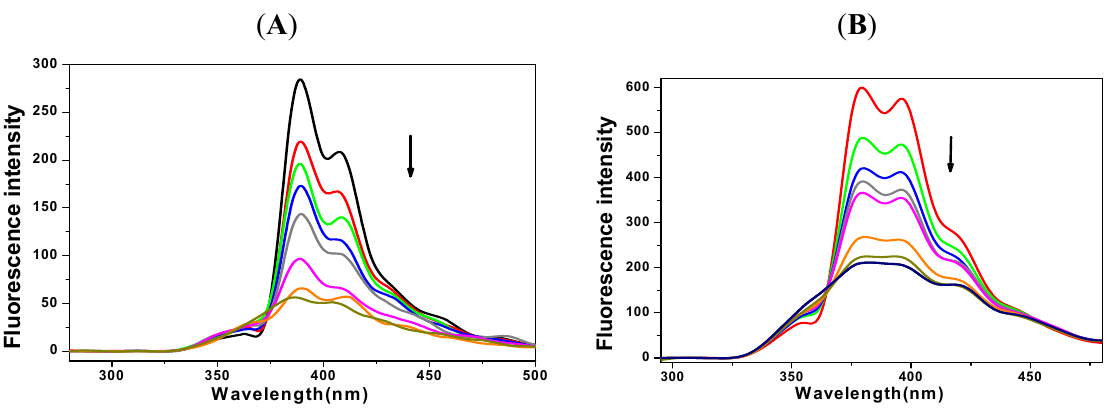
Figure 2. Fluorescence spectra of the pyrene derivatives solution (1  mol/L) with the addition of p53 DNA (0-20  mol/L). ( A ) 1-OHP and ( B ) 1-PBO. The arrows show the fluorescence changes at peak wavelength with the DNA concentration